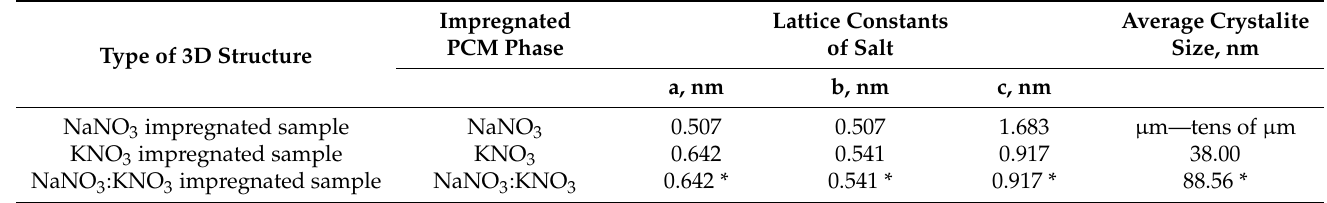
Table 2. Structural parameters (calculated according to XRD data) for the PCM salts impregnated into 3D